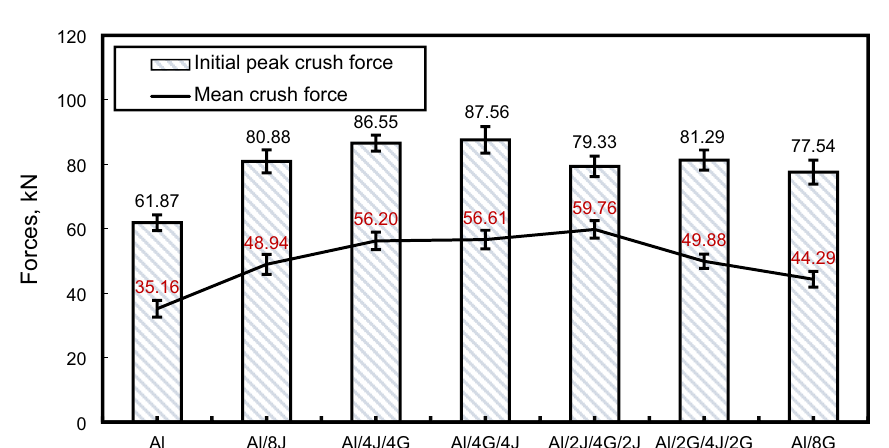
Figure 12. Initial and mean crushing loads for tested specimens.